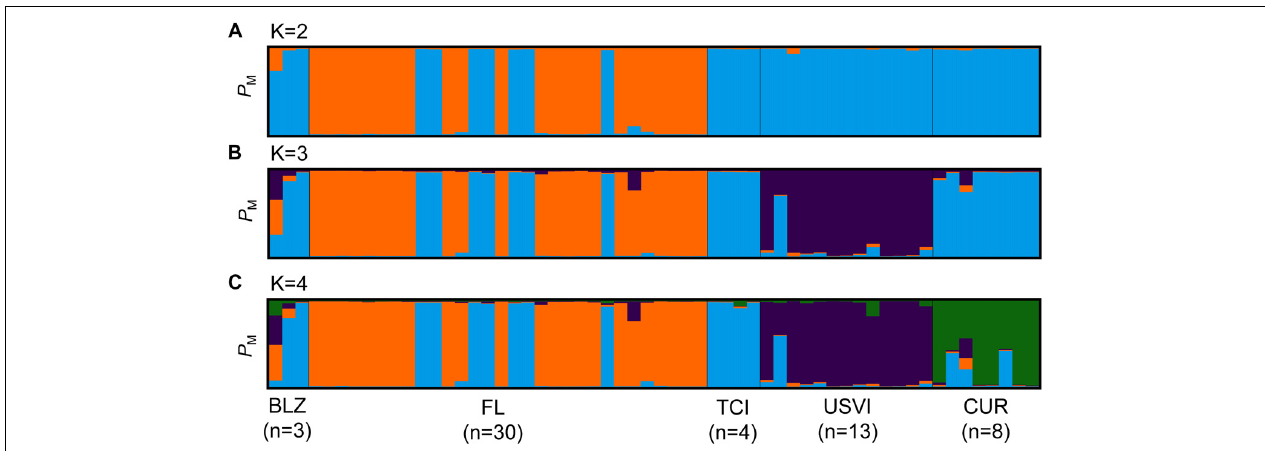
FIGURE 7 | Population structure results for Breviolum dendrogyrum . Each vertical bar represents a unique multilocus genotype. Probability of membership to a cluster is plotted on the y -axis. (A) S TRUCTURE results for B. dendrogyrum when K = 2. (B) S TRUCTURE results when K was set to 3. (C) S TRUCTURE results when K was set to 4. Individuals are grouped by sample location; abbreviations are the same as in Figure 1